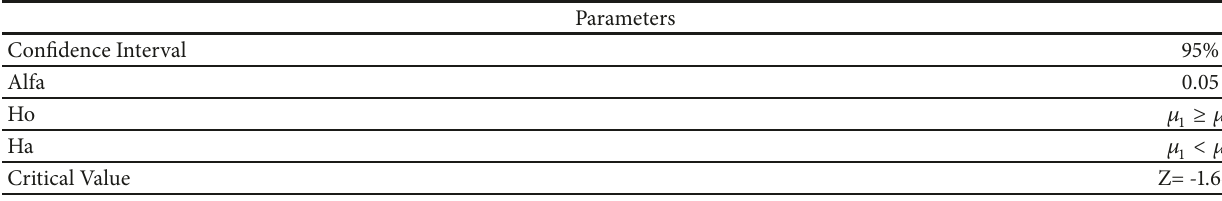
Table 7: Parameters for hypothesis testing modules.